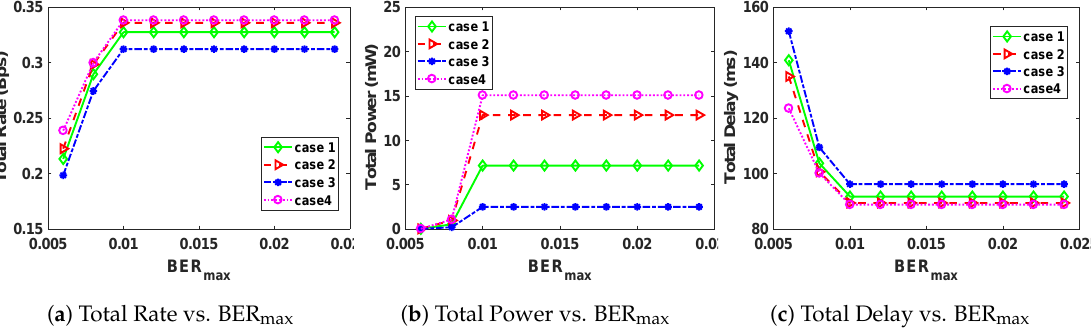
Figure 2. Effect of changing maximum interference BER max , on the optimal rate, power and delay.